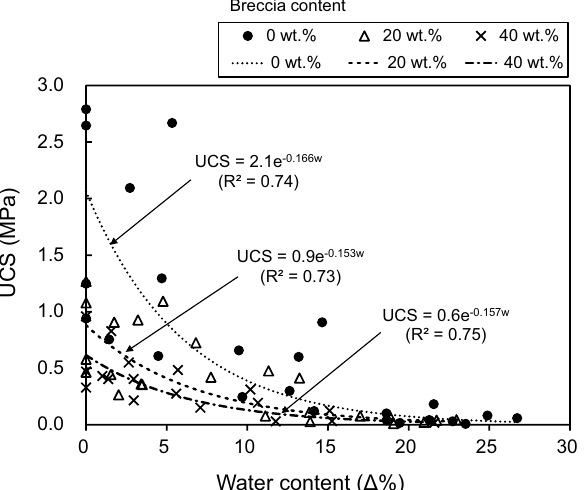
Figure 14. Relationship between unconfined compressive strength (UCS) and water content with respect to three breccia contents (0, 20, and 40 wt.%). The regression models show that UCS is exponentially related to water content for distinct breccia contents of 0, 20, and 40 wt.%.